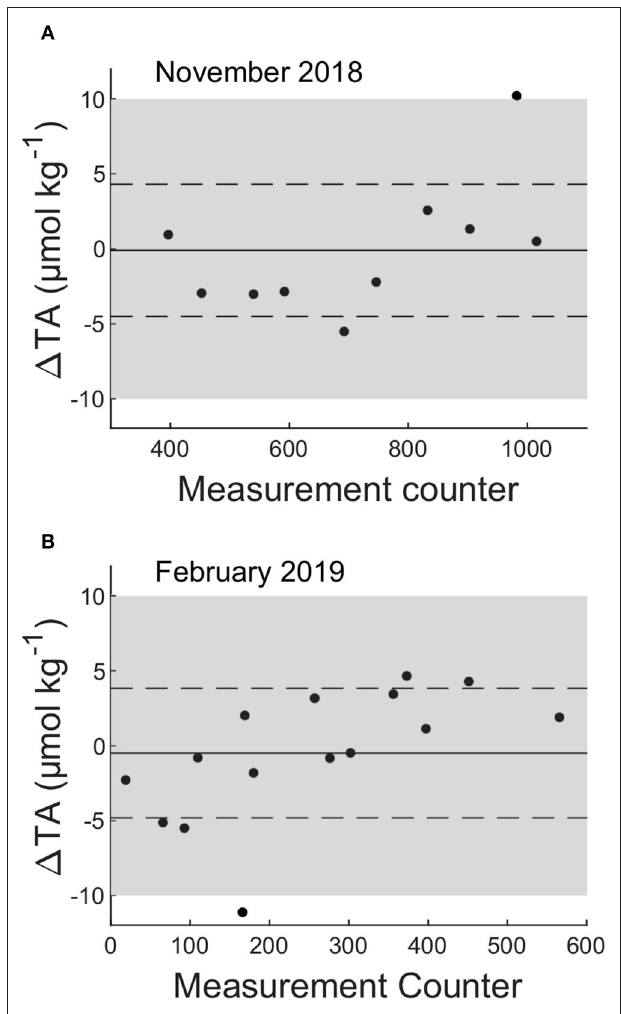
FIGURE 7 | Residuals of the intercomparison of TA measurements between the CONTROS HydroFIA r TA (drift corrected values) and the reference open-cell titrator (VINDTA 3S) for (A) the November 2018, and (B) the February 2019 transit. The horizontal black solid line indicates the averaged bias, 1 TA, and the horizontal black dashed lines indicate 1 TA ± σ ( − 0.2 ± 4.7 µ molkg − 1 for November 2018, and − 0.5 ± 4.3 µ molkg − 1 for February 2019). The gray area represents the uncertainty of ± 10 µ molkg − 1 required by